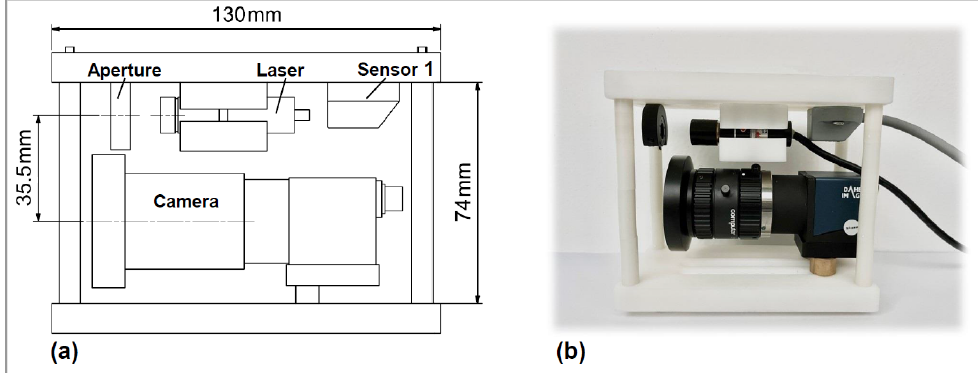
Figure 3. The developed 3D shape measurement unit. ( a ) Structural diagrams. The baseline between the camera and laser light source is 35.5 mm. ( b ) Side view of the prototype.